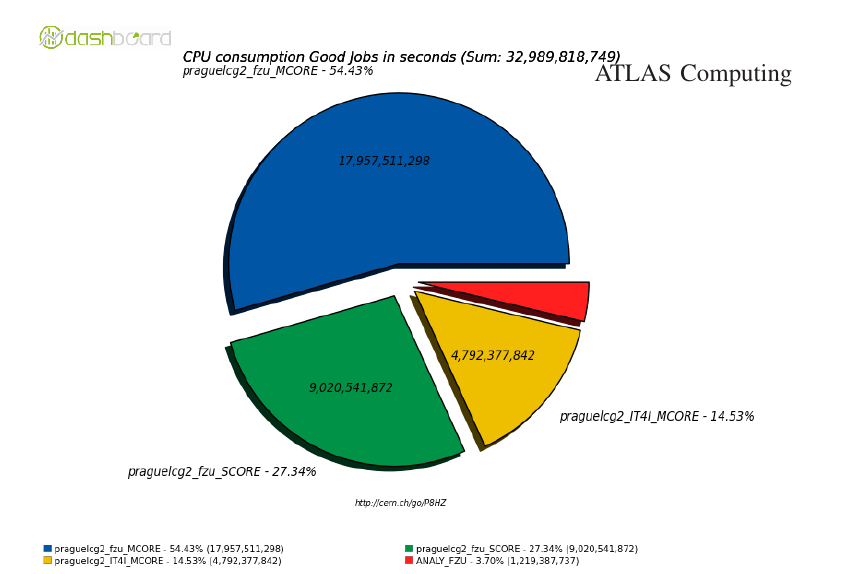
Figure 8. CPU consumption of good jobs for all active praguelcg2 queues. The HPC (praguelcg2_IT4I_MCORE queue) provides significant amount of resources (about